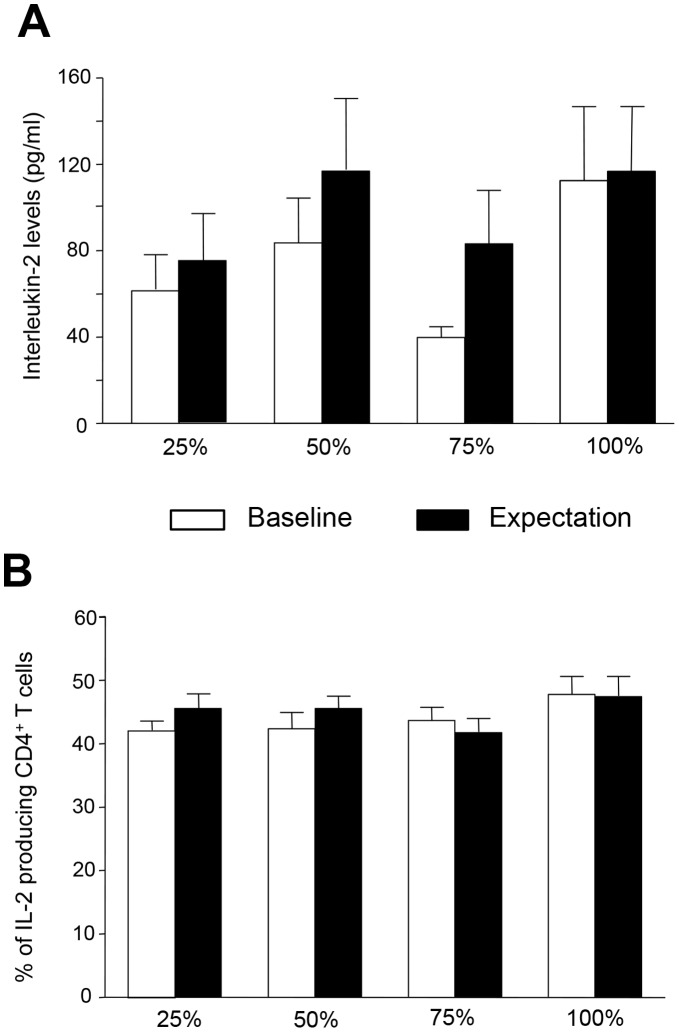
Expectation induced cytokine response.(A) Expectation did not induce a significant reduction in IL-2 production in any of the four expectation groups differing in the probability of receiving CsA. IL-2 (pg/ml) concentration in supernatants of anti-CD3 stimulated PBMC was analyzed before and after placebo pill intake (25% n = 9, 50% n = 8, 75% n = 8, 100% n = 8). Data are shown as mean ± SEM. (B) Expectation did not reduce the percentage of IL-2 producing CD4+T cells. IL-2 producing CD4+T cells were analyzed as percent of total CD4+T cells before and after placebo pill intake. Data are shown as mean ± SEM.